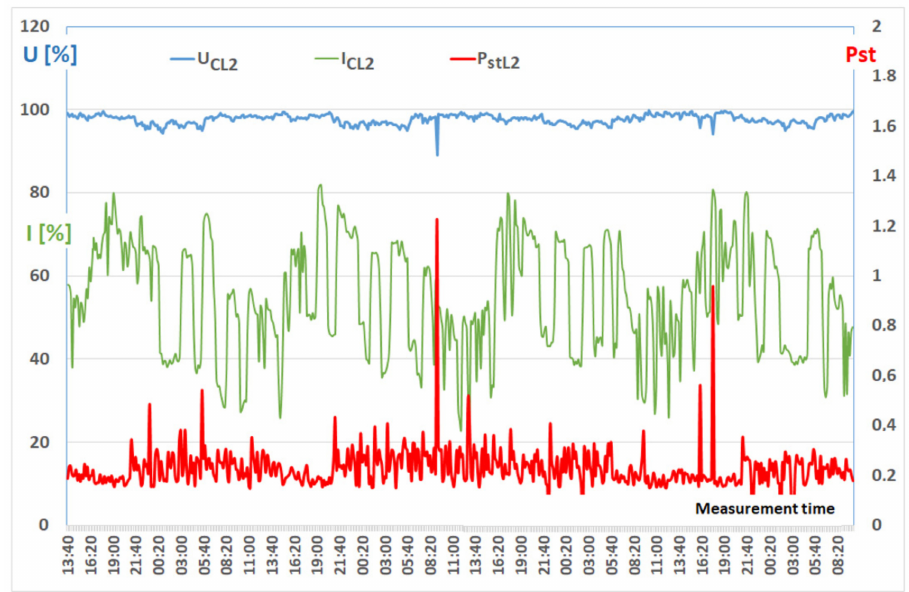
Figure 22. Changes in voltage, flicker coefficient and current recorded in the non-traction needs